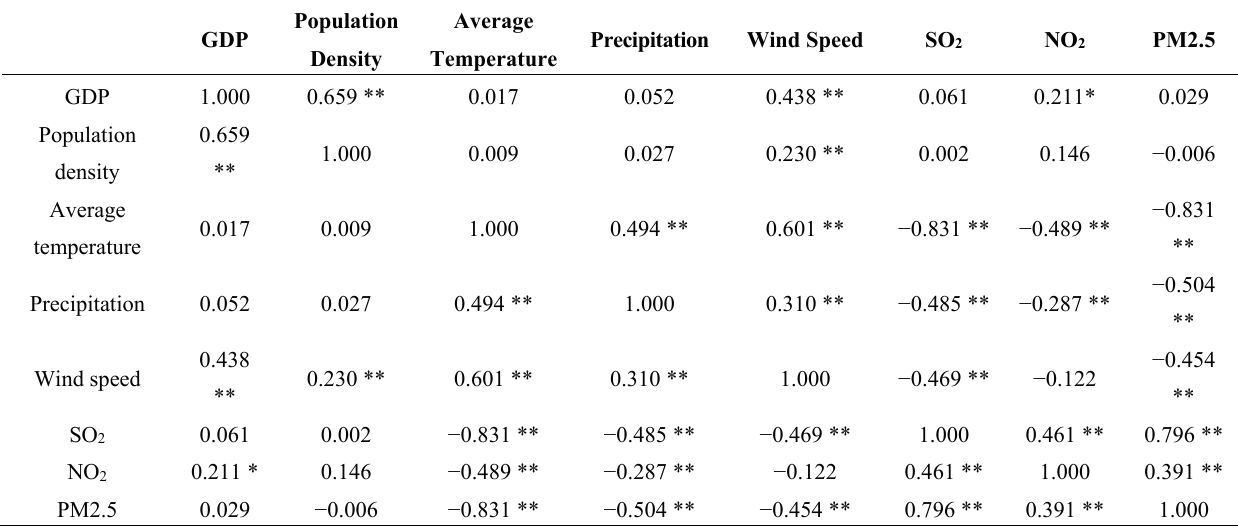
Table 1. Pearson correlation coefficients of influencing factors and PM2.5 concentration in Xi’an,